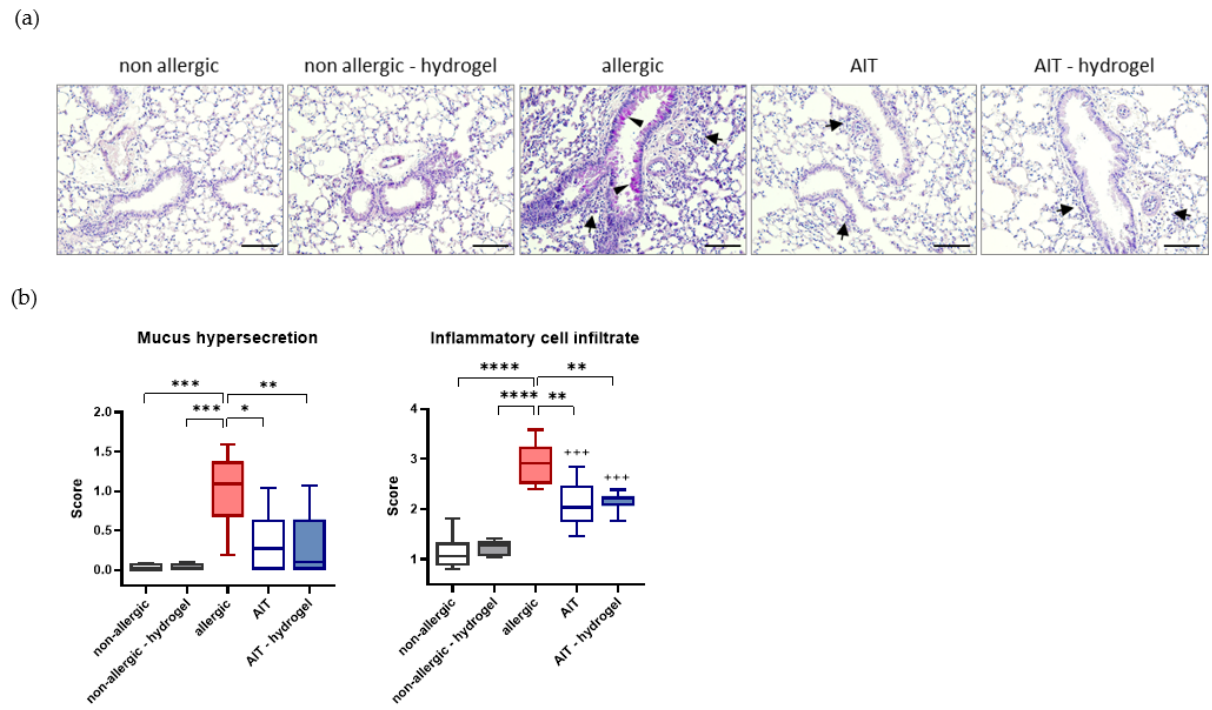
Figure 4. Effects of AIT delivered in hydrogel compared to standard AIT treatment on mucus hypersecretion and infiltration of inflammatory cells in lung tissue. ( a ) Representative lung histology (PAS staining) of non-allergic, non-allergic–hydrogel, allergic, AIT, and AIT–hydrogel groups. Arrows, inflammatory infiltrate; arrowheads, mucus hypersecretion; scale bar: 100 µm. ( b ) Histological scoring of inflammatory cell infiltration and mucus hypersecretion ( n = 6); boxplots indicate minimum, 25th percentile, median, 75th percentile, and maximum. Results were analyzed by one-way ANOVA with Tukey’s test. p -values of ≤ 0.05, ≤ 0.01, ≤ 0.001, and ≤ 0.0001 are shown as *, **, ***, and ****, respectively. p -values of AIT groups compared to the respective non-allergic groups are shown as +++.